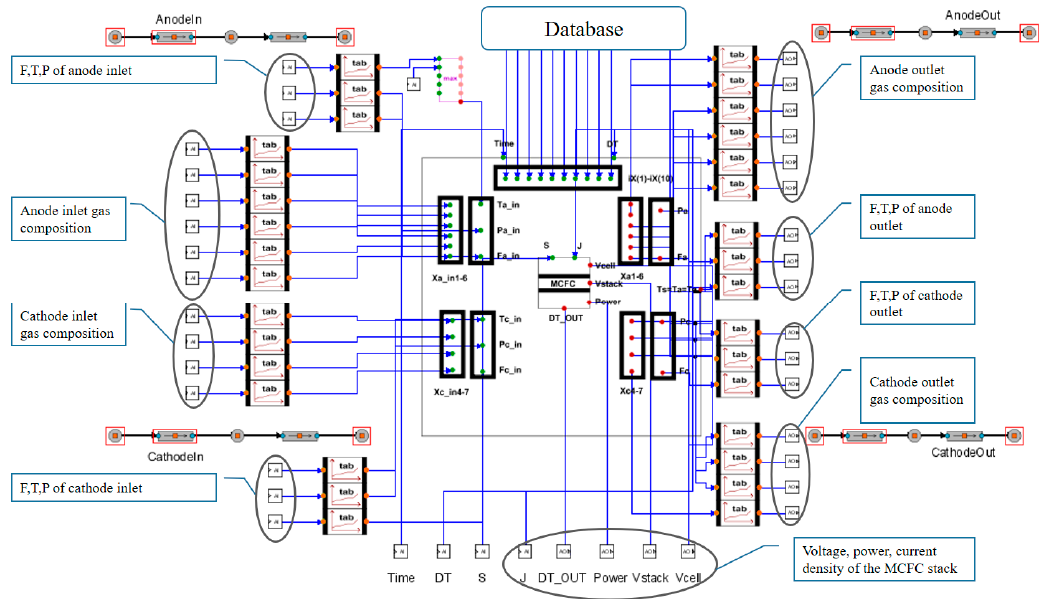
Figure 4. The MCFC stack module developed in Advanced PROcess Simulation (APROS).